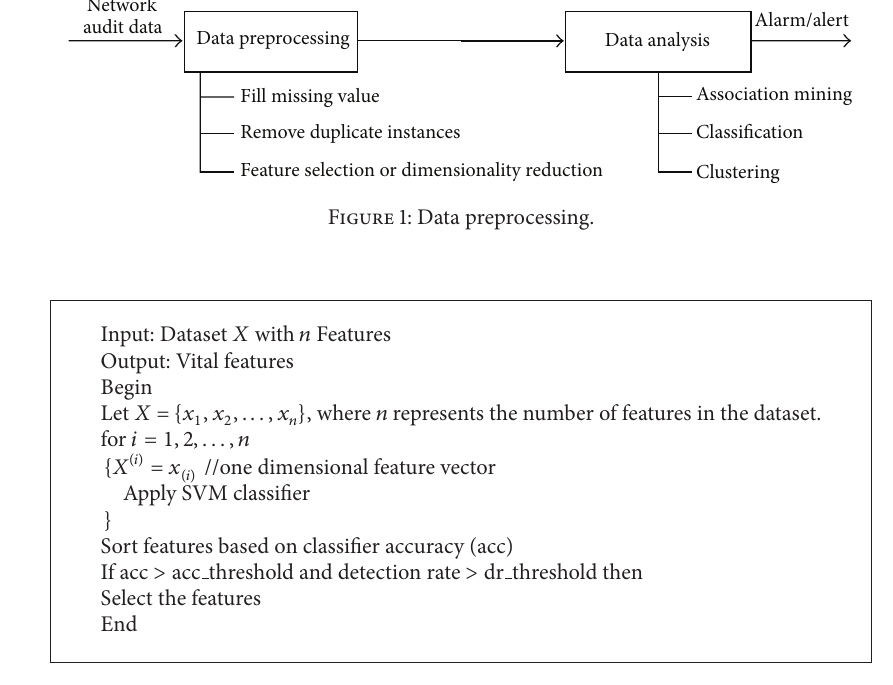
Algorithm 2: Single feature selection method.